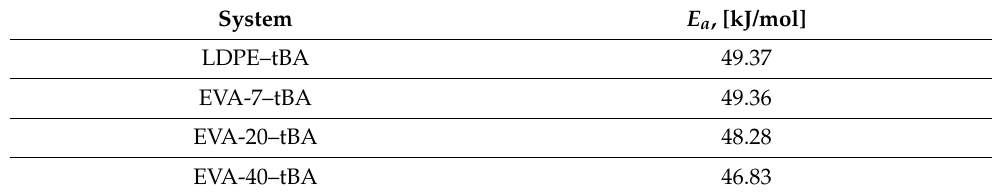
Table 4. Self-diffusion activation energy at ϕ tBA → 0 for LDPE–tBA and EVA–tBA